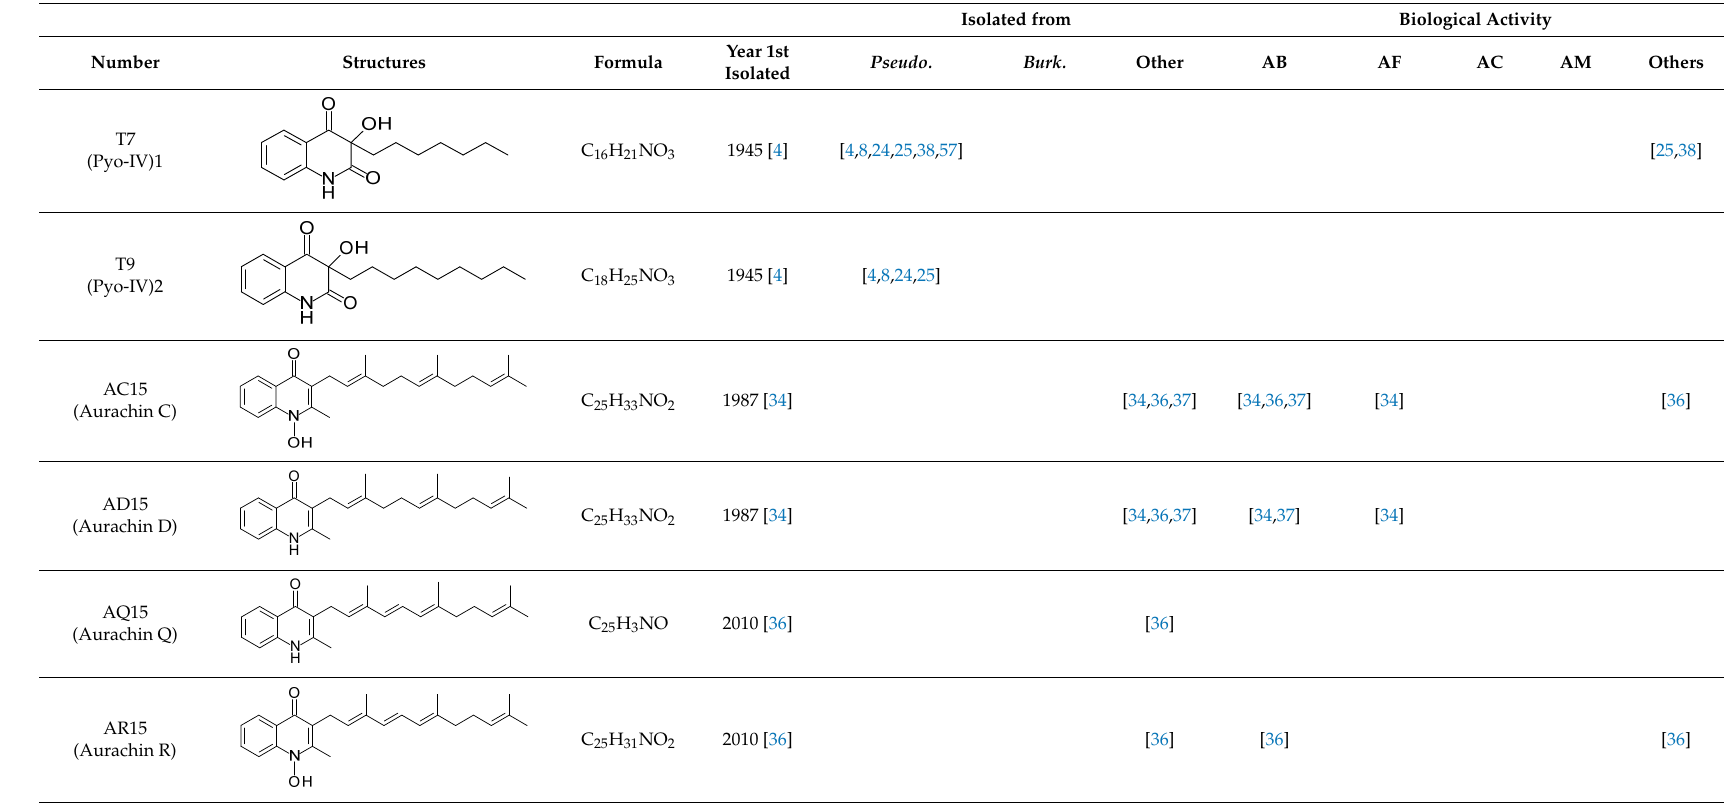
Table A2. Bacterial alkylquinolones with alkyl substitution at position 3 and quinolobactins.